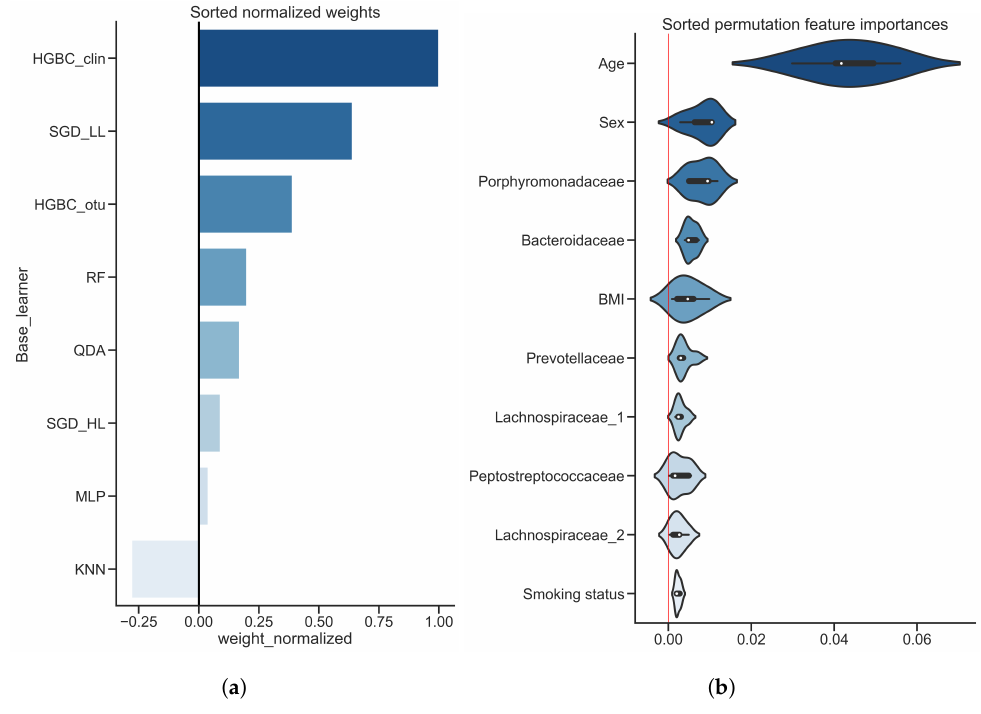
Figure 5. Sorted feature importance values, colorectal cancer dataset, training set. ( a ) Normalized regression weights obtained from a meta learner used in stacked classifier; ( b ) Violin plots of permu- tation feature importance values obtained from a stacked classifier. Red vertical line represents zero importance